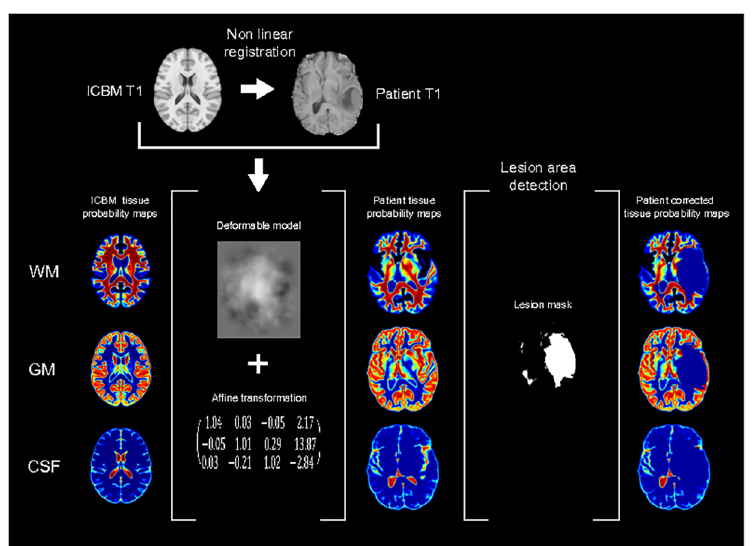
Fig 4. Patient tissue probability maps computation and lesion area